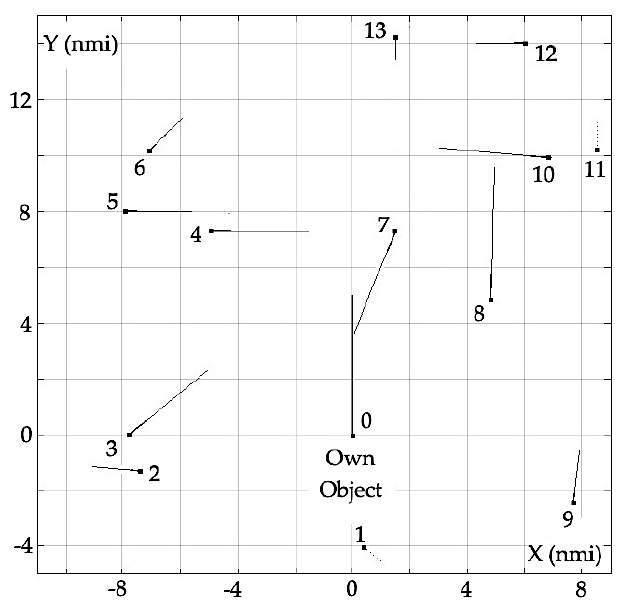
Figure 6. Displaying a computer simulated situation of the own object passing 13 objects encountered in the form of 12-minute velocity vectors.